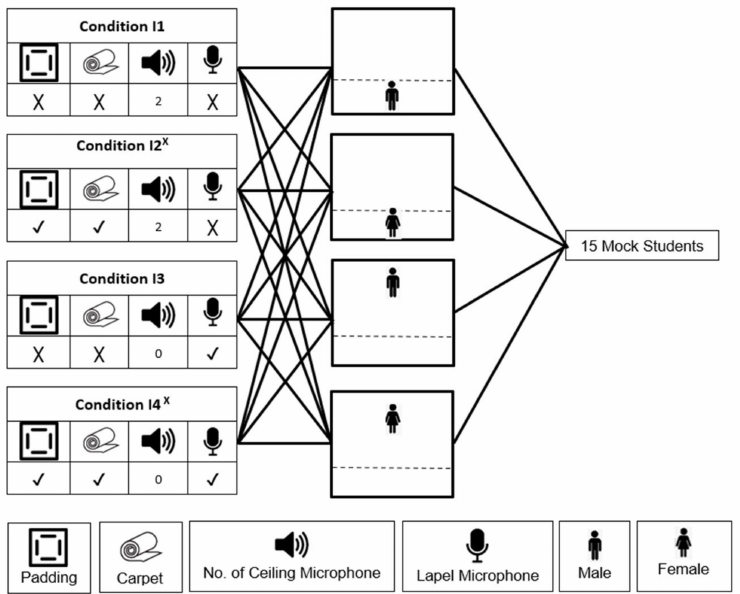
Figure 3. Instructions Conditions and Tests Procedural Flow Chart.